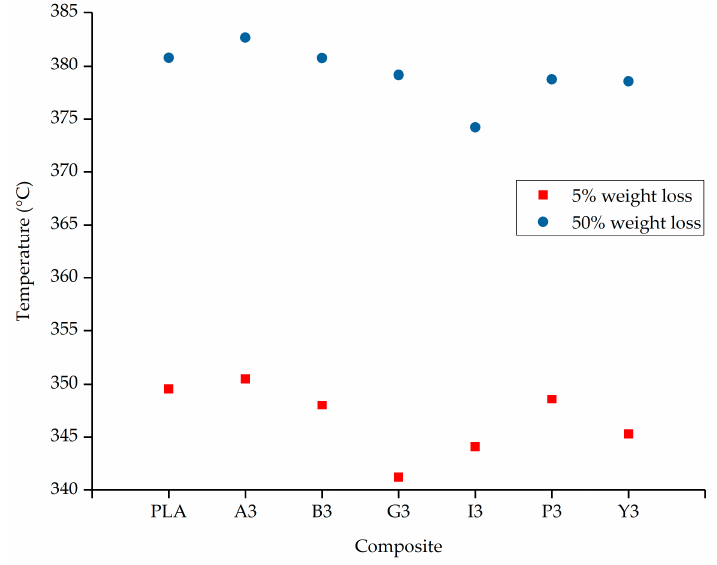
Figure 7. Comparison of 5% and 50% weight loss temperatures for PLA and composites containing 3% (w/w) of each additive.